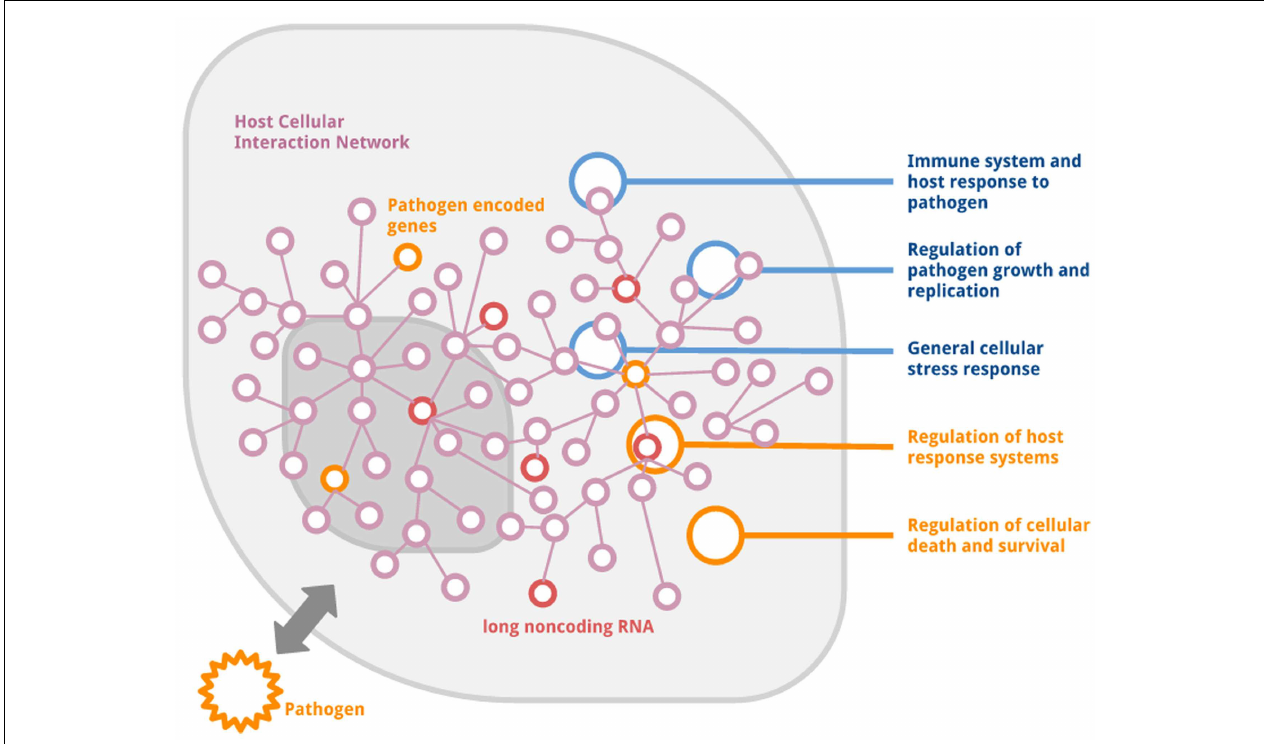
FIGURE 1 | Schematic of the role of long non-coding RNAs in host-pathogen interaction networks.